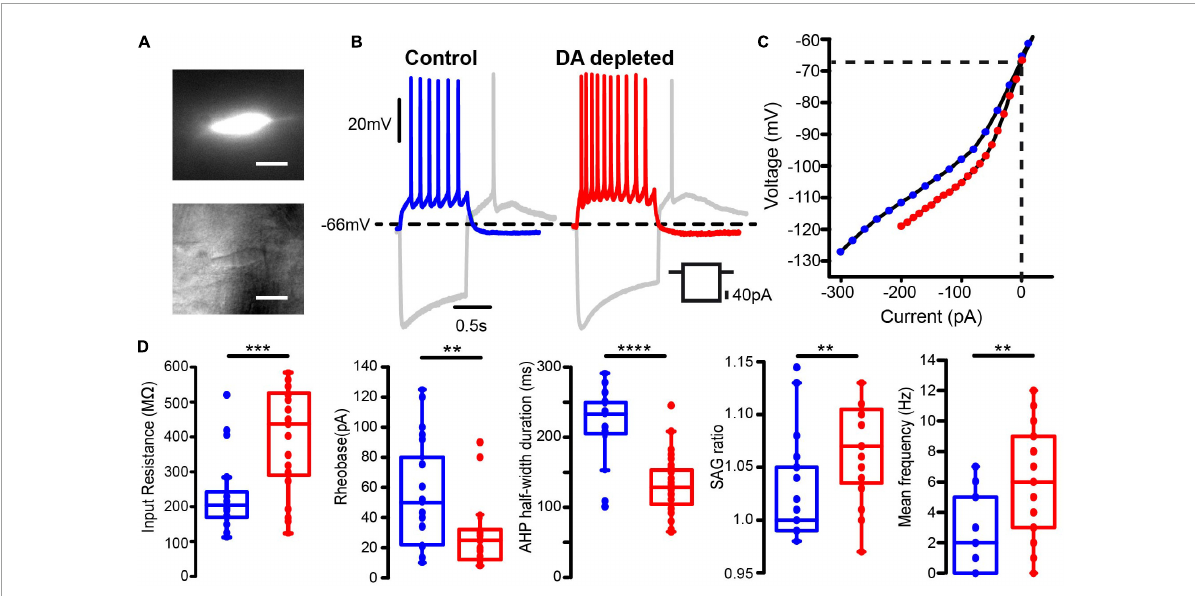
FIGURE2 Increased excitability of dopamine depleted identified cholinergic interneurons revealed by intracellular current injections. (A) Top: Photomicrograph of a ChAT-positive neuron expressing GCaMP6f. Bottom: The same neuron viewed with infra-red (IR) microscopy (Scale bar: 10 µ m) (B) left: Whole-cell patch clamp recordings of a representative cholinergic interneuron (CIN) from the control striatum. Right: Recordings of a CIN from dopamine (DA) depleted striatum (6-OHDA model). Voltage responses evoked by hyperpolarizing and depolarizing current injections are compared. (C) Representative current-voltage (I-V plot) relationships of CINs in each condition. (D) Box-plots comparing neuronal input resistance, rheobase, sag ratio and mean firing frequency upon 1 s, 40 pA depolarizing current for samples in both conditions. The half-width duration was measured during spontaneous firing at similar frequencies: 3–4 Hz (Mann–Whitney U -test: ** P < 0.01; *** P = 0.0008;**** P <